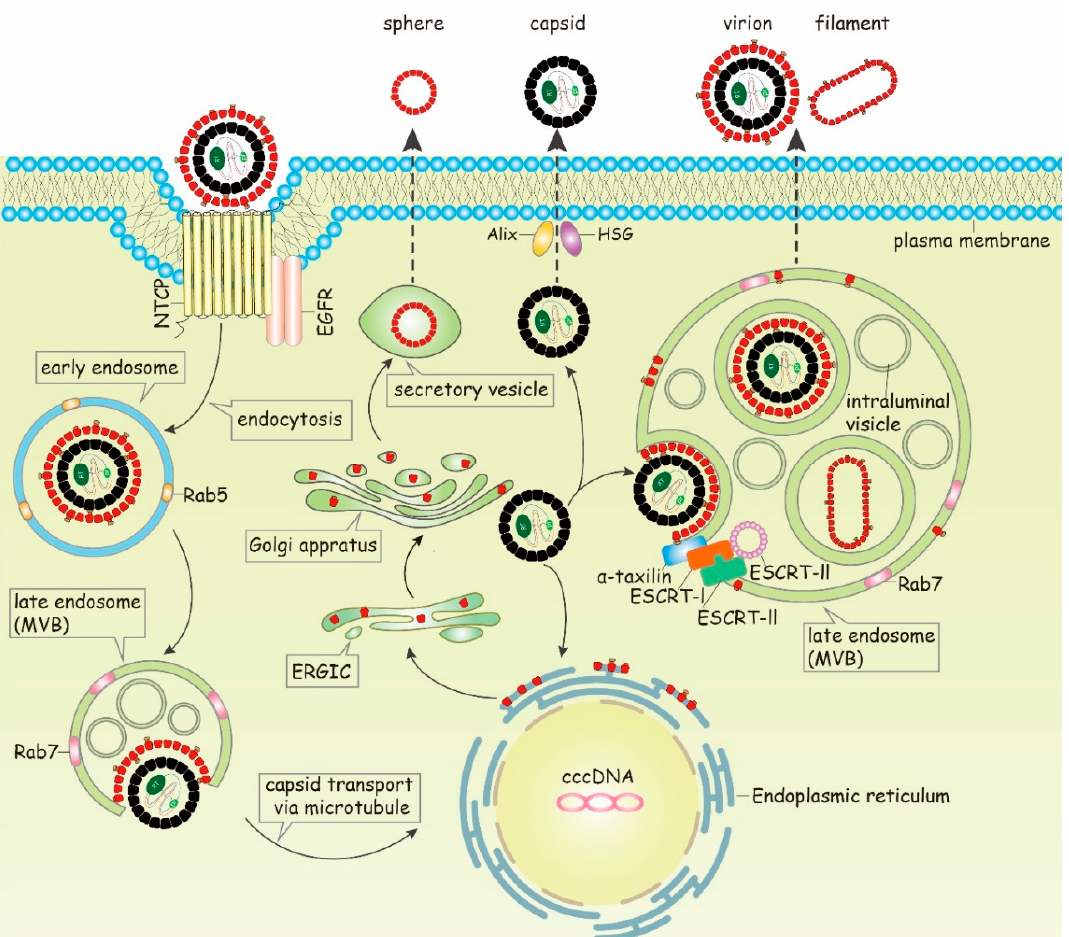
Figure 2. Model of HBV intracellular trafficking. After binding to the receptor complexes (NTCP = Sodium taurocholate cotransporting polypeptide), the virions are transported to Rab5-containing early endosomes followed by the Rab7-containing late endosomes. After their release into cytoplasm, the nucleocapsids are delivered to the nuclear pore complex by a directed transport involving microtubules. In the nuclear pore complex the nucleocapsid disassembles and the viral DNA genome is imported into the nucleus and converted to cccDNA (covalently closed circular DNA). In the early phase of the infection process, de novo synthesized nucleocapsids are transported back to the nuclear pore complex to augment the cccDNA pool in the nucleus. Later in the infection process, the surface proteins are synthesized at the rough ER (endoplasmatic reticulum) and transported through the ERGIC (ER-Golgi-intermediate-complex). Spheres are secreted by the constitutive secretory pathway. After envelopment of the nucleocapsid, the release of virions as well as of filaments is ESCRT/MVB-dependent and mediated by α -taxilin. In addition, non-enveloped assembled (nucleo)capsids are secreted as naked capsids involving Alix and HSG. (MVB = multivesicular bodies; ESCRT = endosomal sorting complexes required for transport; EGFR = epidermal growth factor receptor)